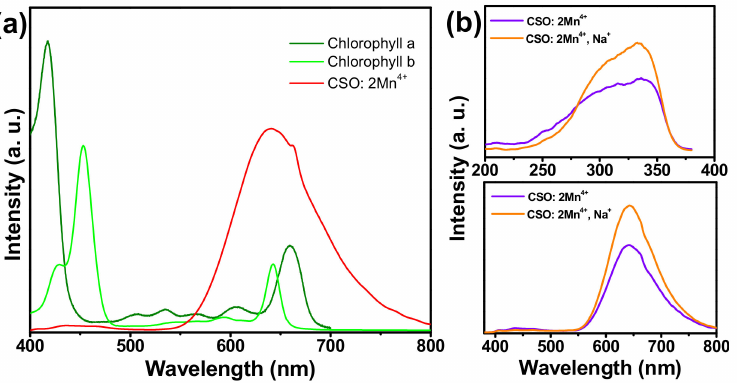
Figure 5. ( a ) Comparison of PL spectrum of CSO: 2Mn 4+ and absorption spectra of chlorophyll a and chlorophyll b. ( b ) PLE and PL spectra of Na + -doped CSO: 2Mn